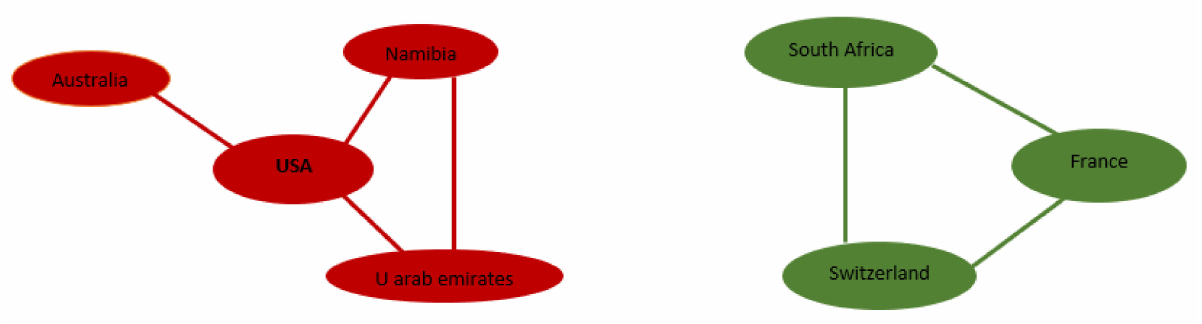
Figure 4. The country collaboration network derived from southern African published